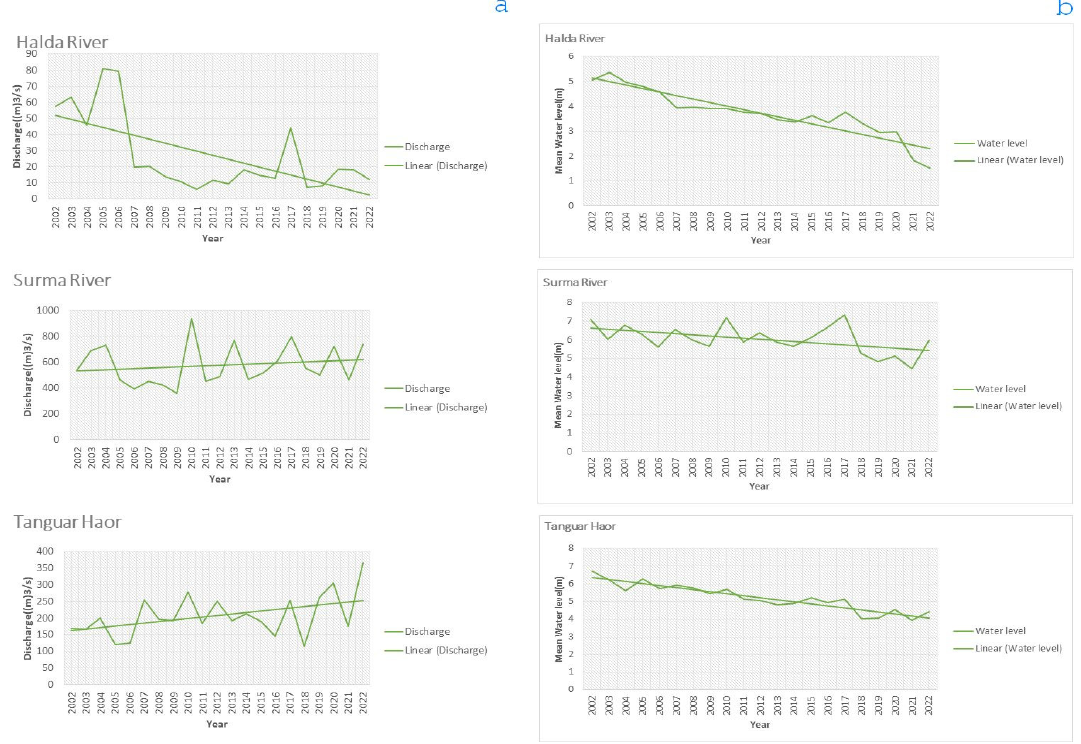
Figure 5. Graphical representation of the yearly mean discharge ( a ) and water level ( b ) value of the last 20 years of the study area.